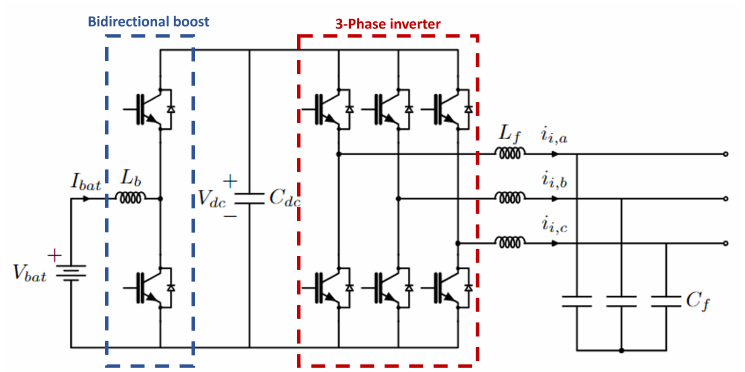
Figure 2. Converter dual stage topology with bidirectional boost converter and two-level three-phase inverter with LC filter.